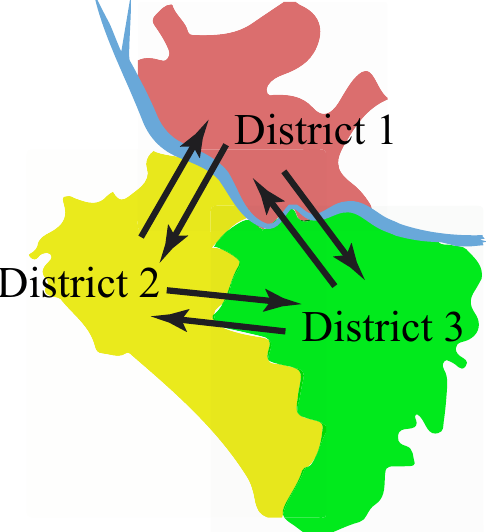
Figure 1. Schematic representation of a territory with interacting